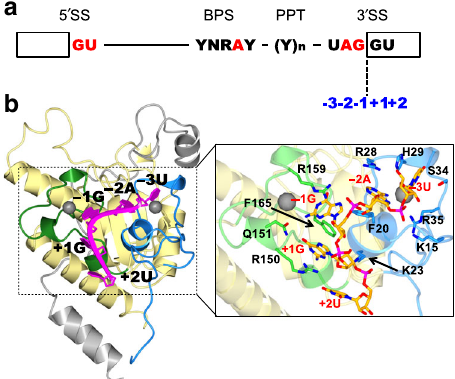
Fig. 1 Structure of the U2AF1 complex bound to 3 ′ splice site RNA. a Sequence elements required for splicing. Boxes indicate exons; Y pyrimidine, R purine, N any nucleotide, 5 ′ SS 5 ′ splice site, BPS branch-point sequence, PPT polypyrimidine tract, 3 ′ SS 3 ′ splice site. The dotted line indicates the exon boundary at the 3 ′ splice site, and numbers indicate the distance from the boundary. b Crystal structure of U2AF1 complexed with RNA, 5 ′ -UAGGU. The N-terminal zinc fi nger (2-43, ZF1), U2AF homology motif (UHM, 44-141), C-terminal zinc fi nger (ZF2, 143-170), U2AF2 fragment (105 – 159), and RNA are colored blue, yellow, green, gray, and magenta, respectively. Inset: close-up view of the RNA-binding region in U2AF1. RNA is shown in stick representation colored with